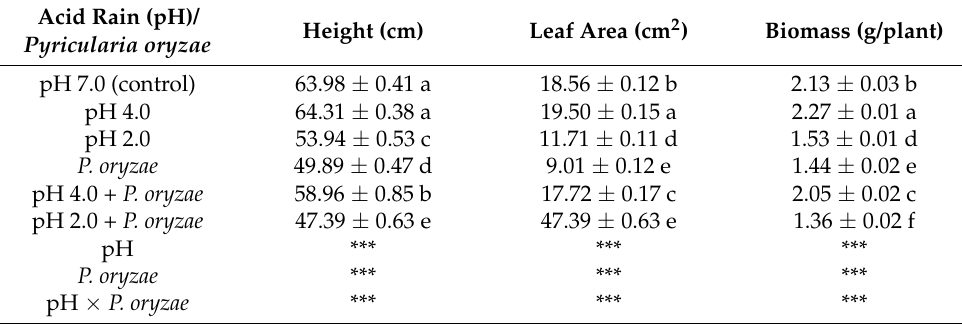
Note: In the same column, significant difference at p < 0.05 was shown with different lowercase. Asterisks indicate the results of two-way ANOVA: ***, p < 0.001. Values are the average ± standard error ( n =